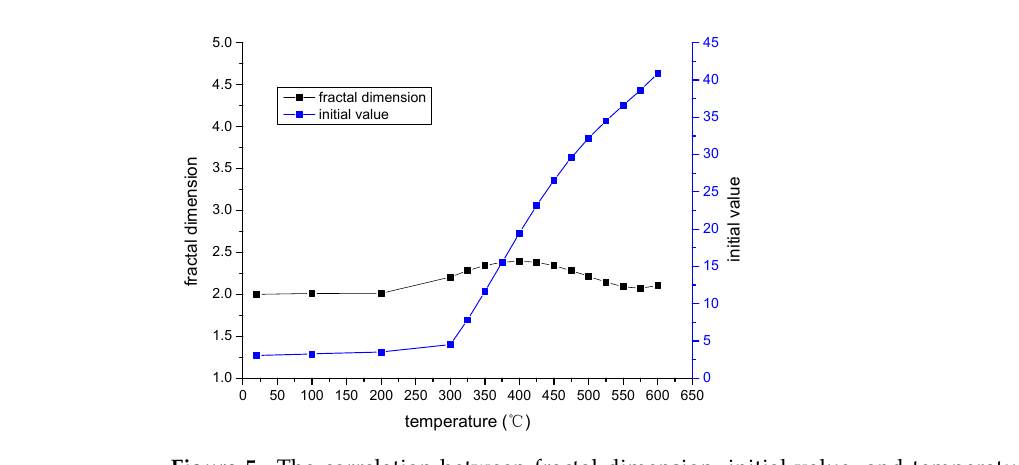
Figure 5. The correlation between fractal dimension, initial value, and temperature of the first group samples.